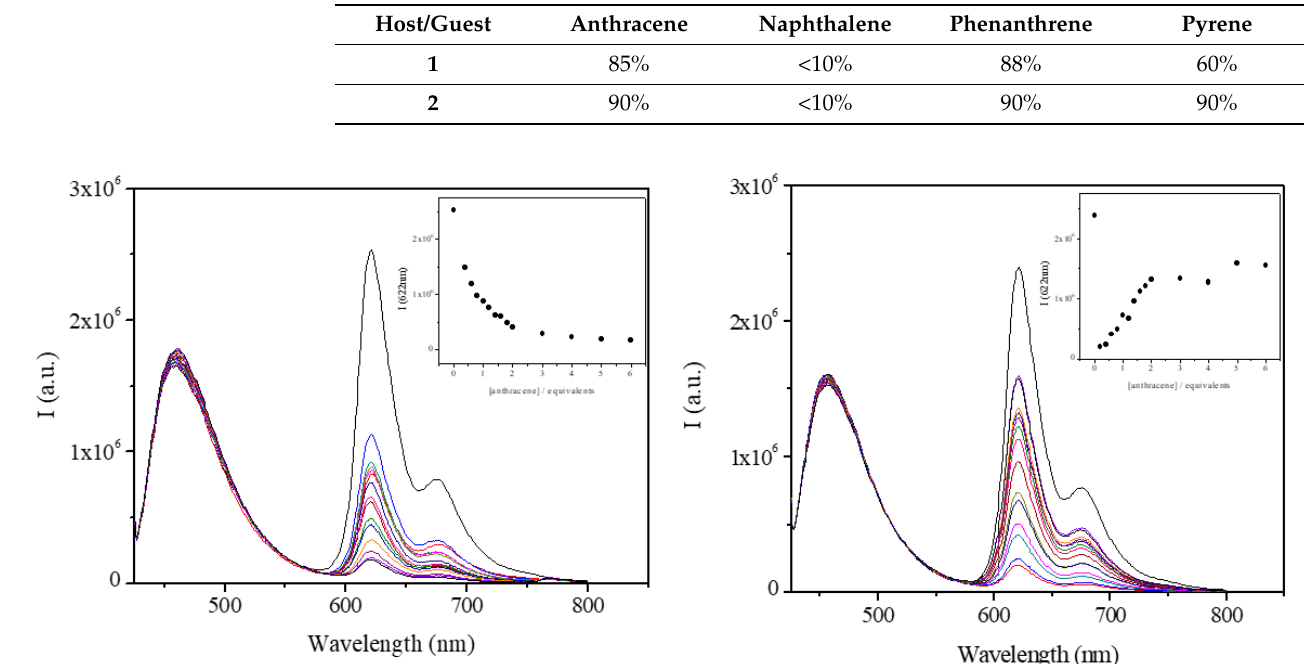
Figure 5. Emission spectra of 1 ( left ) and 2 ( right ) in the presence of different amounts of anthracene. Inset: variations of the emission maxima at 622 nm against [anthracene].